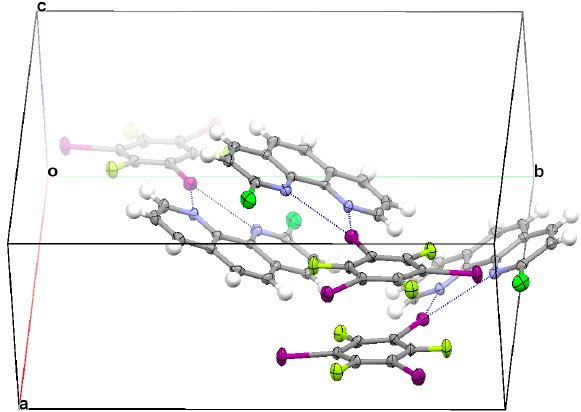
Figure 2. Part of the crystal structure of I showing the formation of an asymmetrical bifurcated halogen bond, π · · · π stacking interaction between two TFTIB molecules, and π · · · π stacking interaction between two ClPHEN molecules